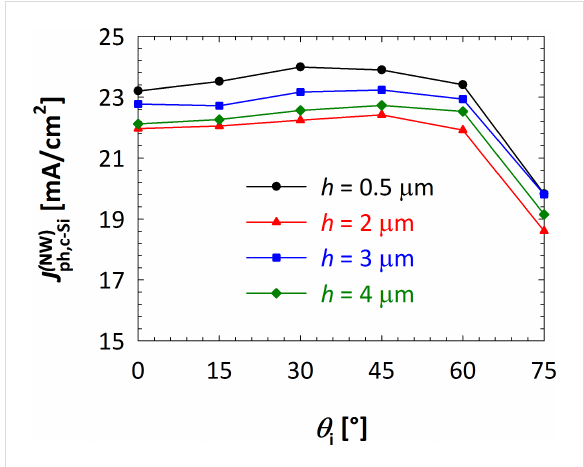
Figure 7: Calculated implied photocurrent density inside the c-Si layer as a function of the angle of incidence of light, for different values of the nanowire height and fixed period ( Λ = 800 nm) and cross section ( d = 200 nm). For clarity of the picture, only selected results are included ( h = 0.5, 2, 3 and 4 μ